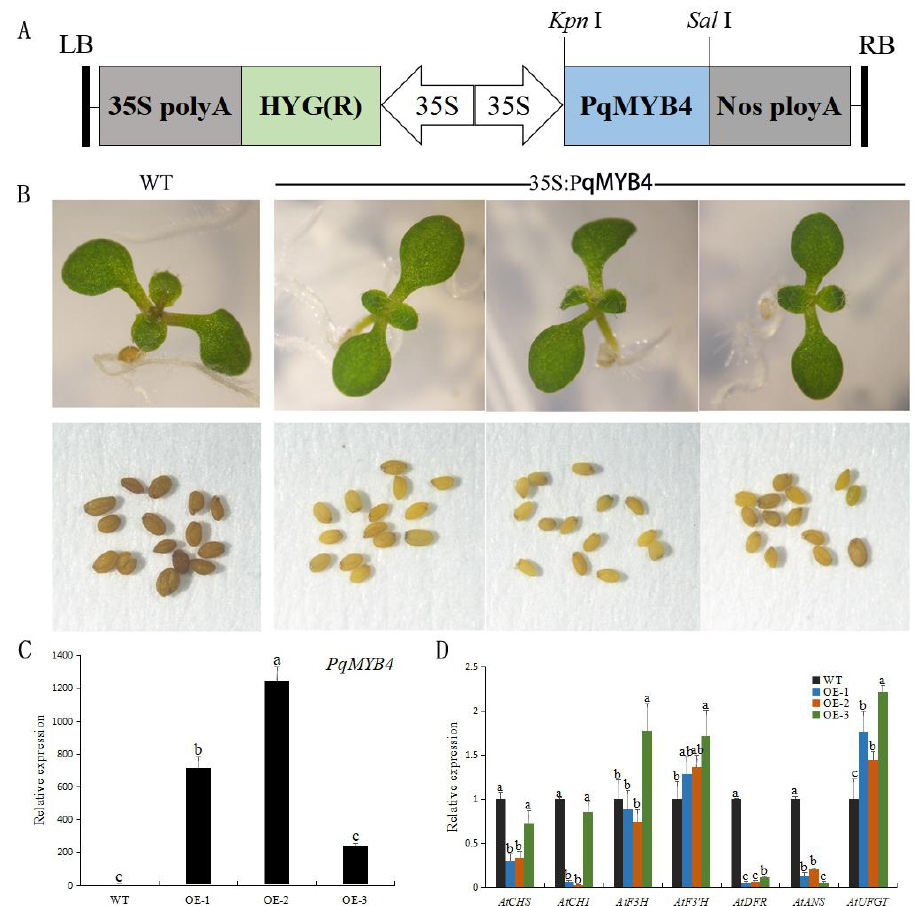
Figure 8. Diagrammatic presentation of vector construct, phenotype and the effect of PqMYB4 overexpression in transgenic Arabidopsis plants. ( A ) diagrammatic presentation of vector construct; ( B ) phenotype; ( C ) the expression level of PqMYB4 gene; ( D ) the expression level of anthocyanin-related structure genes, AtCHS , AtCHI , AtF3H , AtF3′H , AtDFR , AtANS , AtUFGT . a, b and c indicate significant differences at p ≤ 0.05 level by Duncan test.